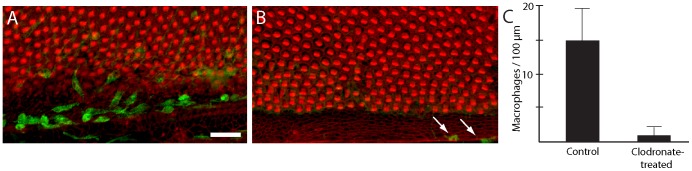
Treatment with liposomally-encapsulated clodronate reduces the number of macrophages in cochlear cultures. (A) Untreated cochlear cultures possess numerous macrophages (green), particularly in the hyaline/cuboidal cell region. (B) After treatment for 24 hr in clodronate-containing liposomes, very few macrophages remain (arrows). In contrast, hair cell morphology did not appear to be affected by clodronate treatment (red: phalloidin). (C) Quantification of macrophages in clodronate-treated vs. control cultures (n = four samples/specimen from eight clodronate-treated and six control cochleae) demonstrates a sharp reduction in the resident macrophage population after clodronate treatment (p<0.001). Scale bar = 30 µm.